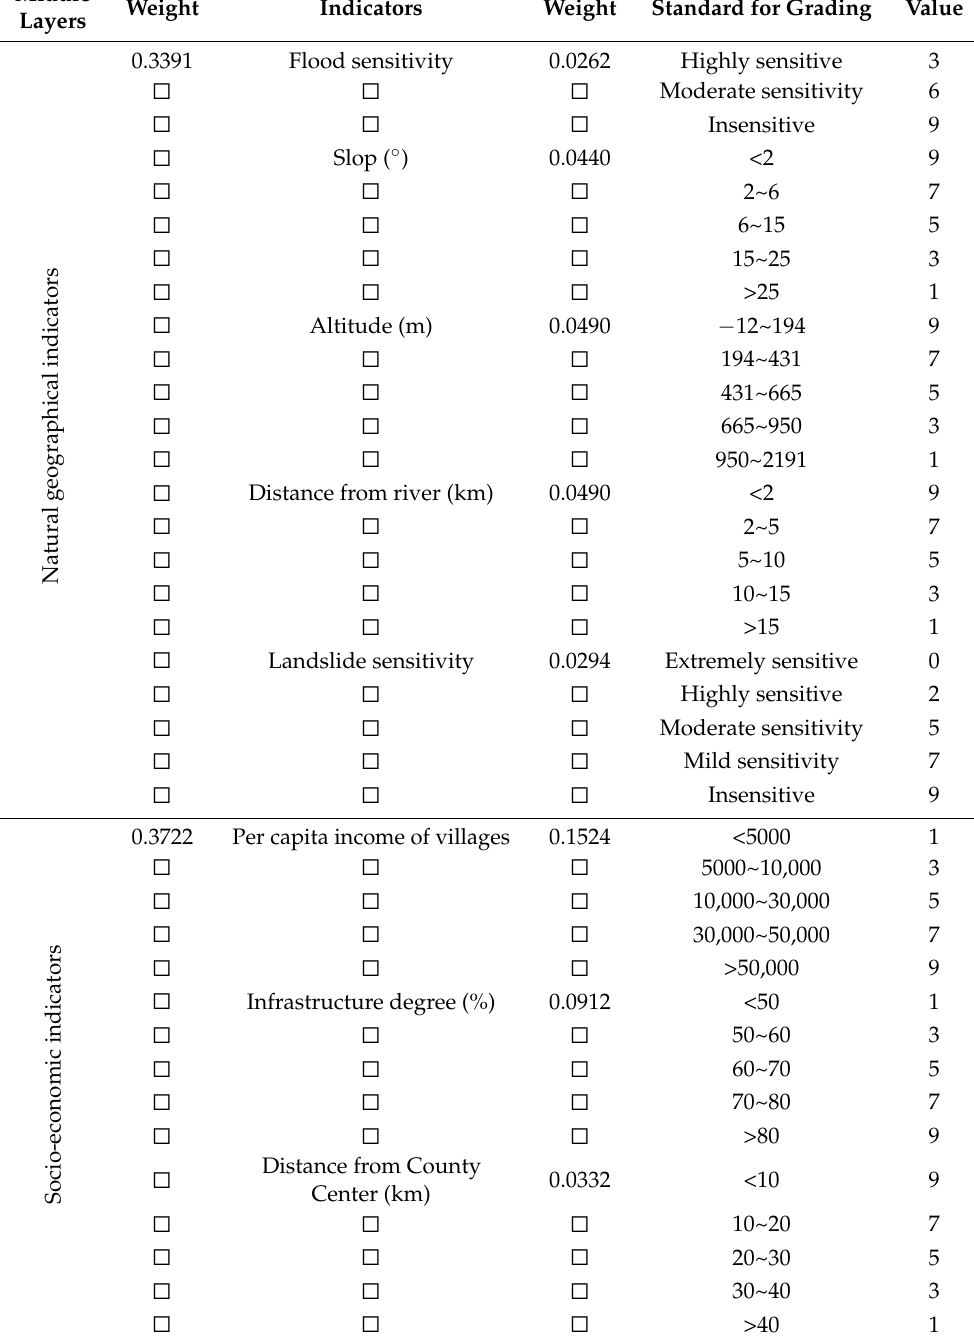
Middle Layers Weight